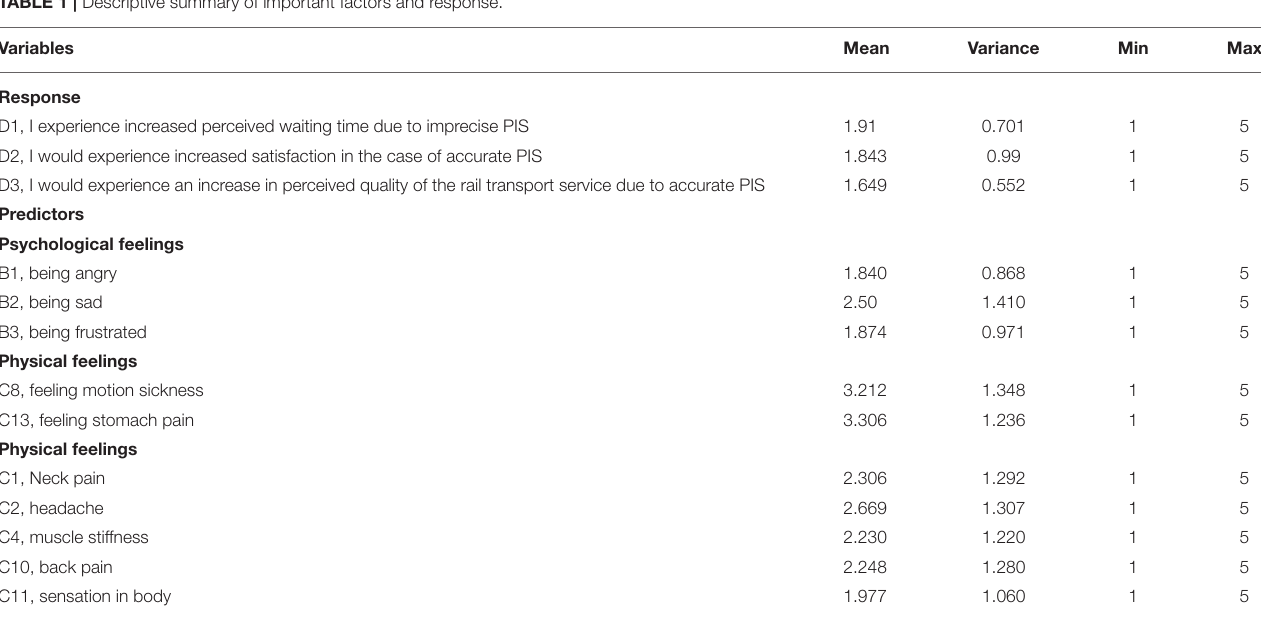
TABLE 1 | Descriptive summary of important factors and